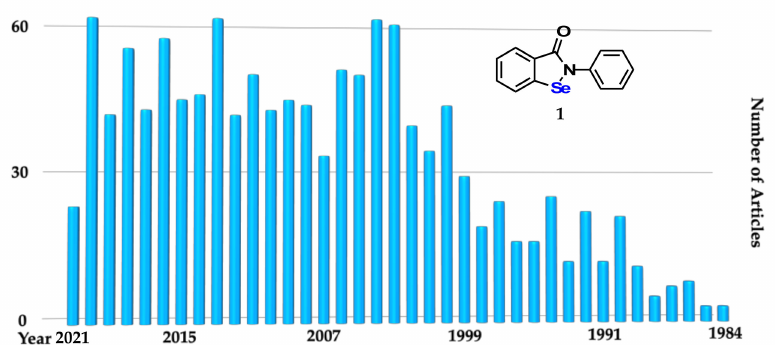
Figure 1. Number of articles on ebselen ( 1 ) from